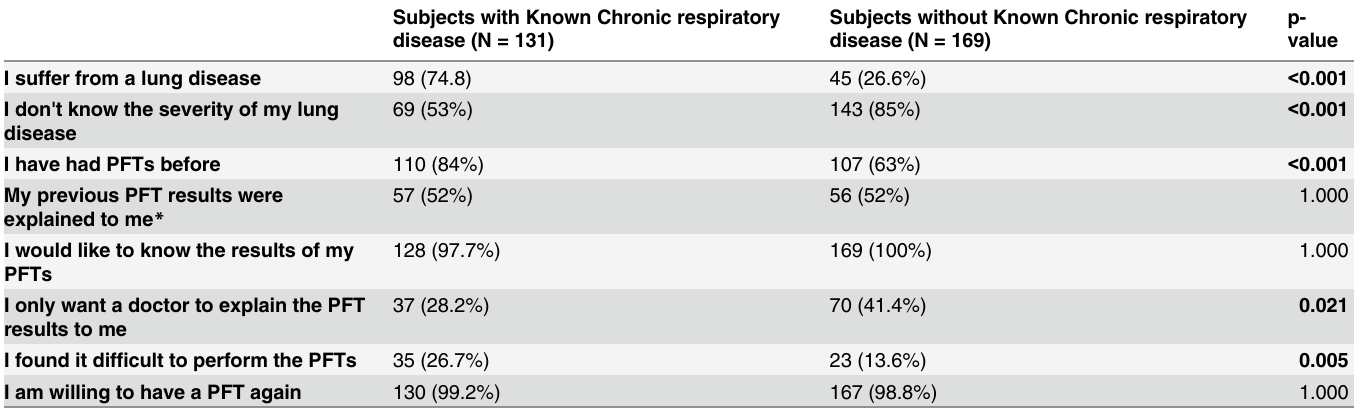
Table 2. Respondents Beliefs Relating to Pulmonary Function